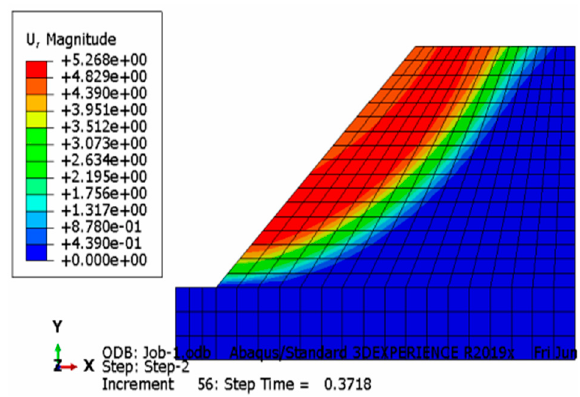
Figure 9. Displacement cloud diagram when slope is unstable at room temperature .